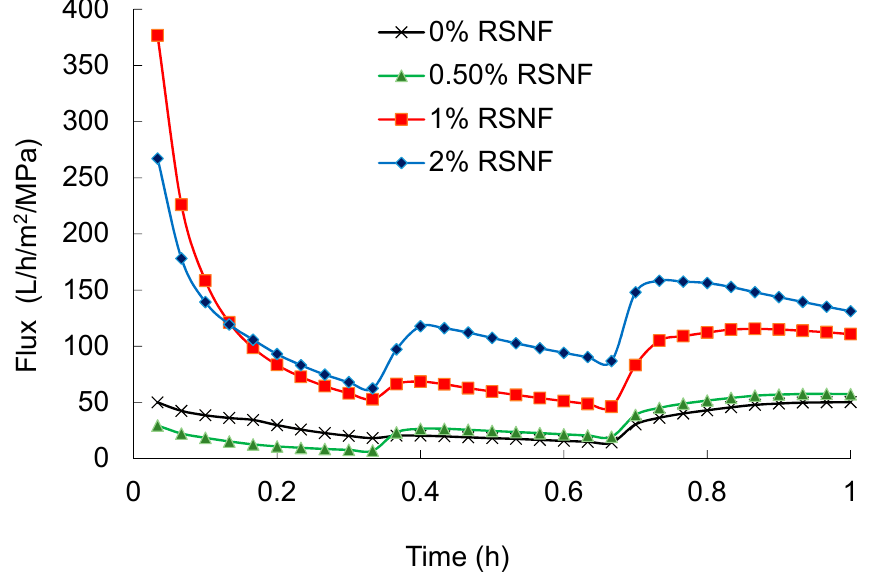
Figure 4. Water flux of PSF and PSF/RSNF membranes with different loadings of RSNF.